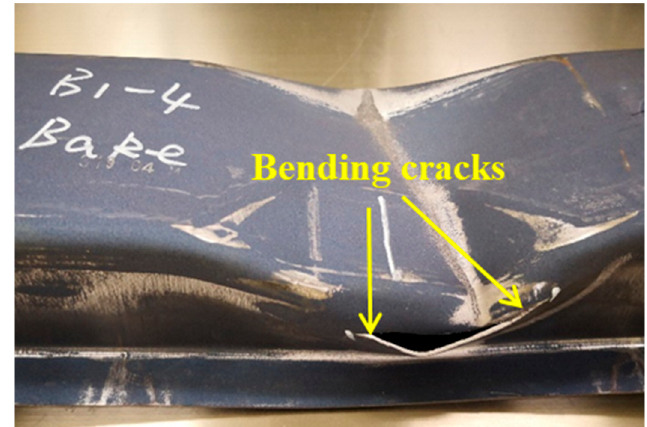
Figure 11. Cracks in a hot-stamped front bumper beam due to local bending after a static three-point bending test [7].